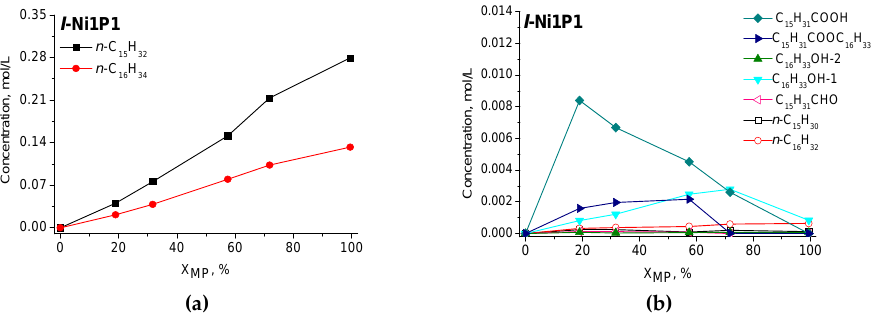
Figure 7. Concentration profiles of the liquid ‐ phase components during methyl palmitate HDO over l ‐ Ni1P1 catalyst: ( a ) the main products—C 15 and C 16 hydrocarbons; ( b ) the observed intermediates. Reaction conditions: P H2 = 3.0 MPa, T = 290 °C, H 2 /feed = 600 Nm 3 /Nm 3 , LHSV = 0.3–3.2 h − 1 .